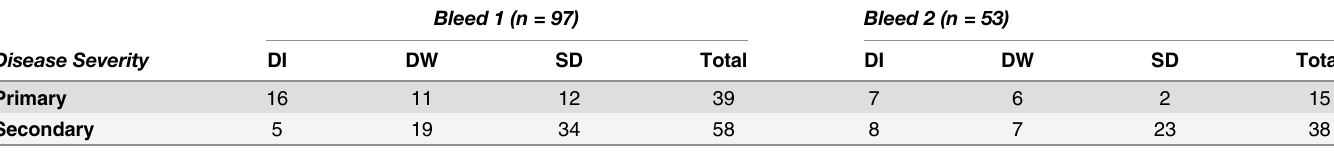
Table 3. Disease severity of enrolled patients at the time of admission (bleed 1) and repeat bleeds at around 48 h post-admission (bleed 2) with pri- mary and secondary dengue infections. Bleed 1 (n = 97) Bleed 2 (n = 53) Disease Severity DI